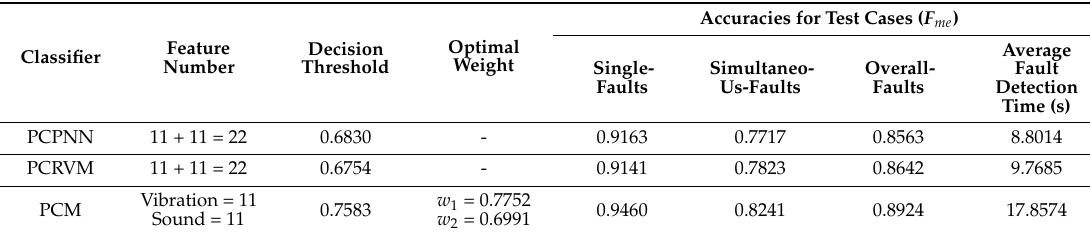
Table 10. Evaluation result of PCM, PCPNN and